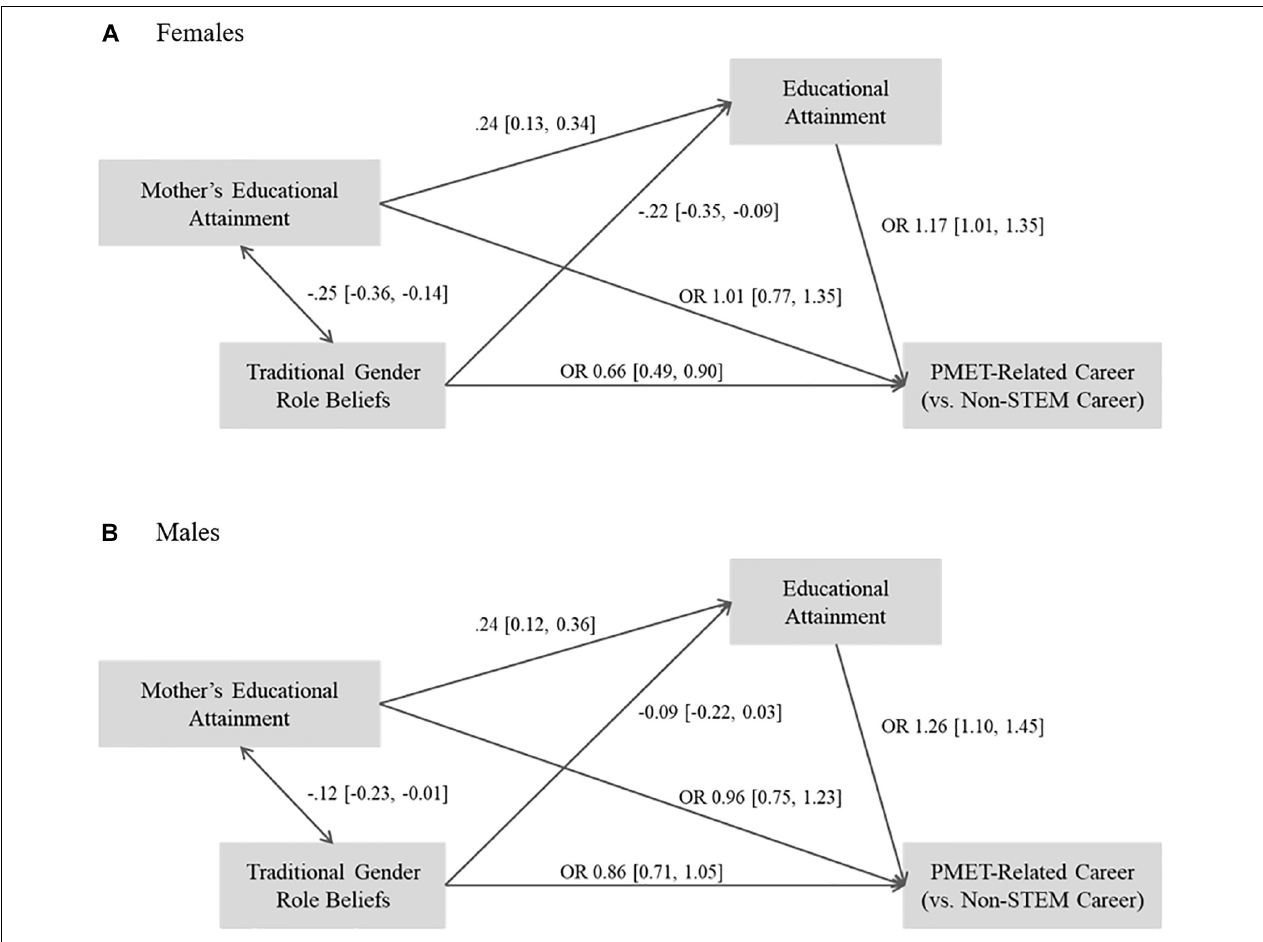
FIGURE 3 | Results of multi-group path analyses by gender for PMET-related careers vs. non-STEM careers. (A) Results for females and (B) results for males. Standardized coefficients are shown for continuous variables. OR, Odds Ratio. 95% Confidence intervals in brackets. Confidence intervals excluding 0/1 for regression coefficients/odds ratios indicate statistical